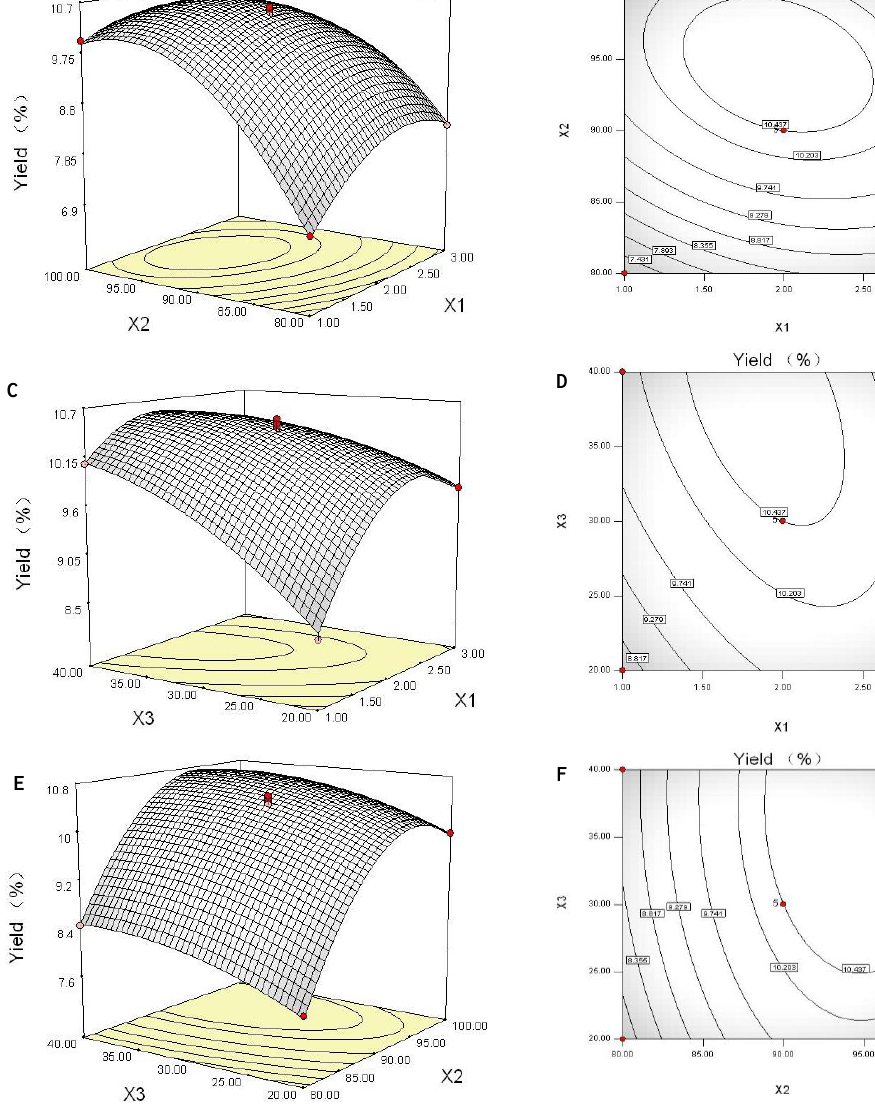
Figure 2. Three-dimensional response surfaces ( A , C and E ) and contour plots ( B , D and F ), showing the effects of extraction time ( X volume (mL) to raw material weight (g) ( X interaction on WPS yield ( Y ).